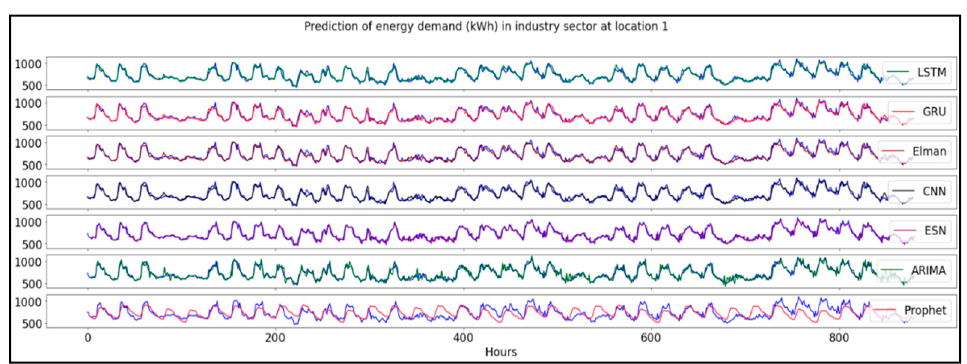
Table 1. Results from 1-h prediction for all cases with all models.